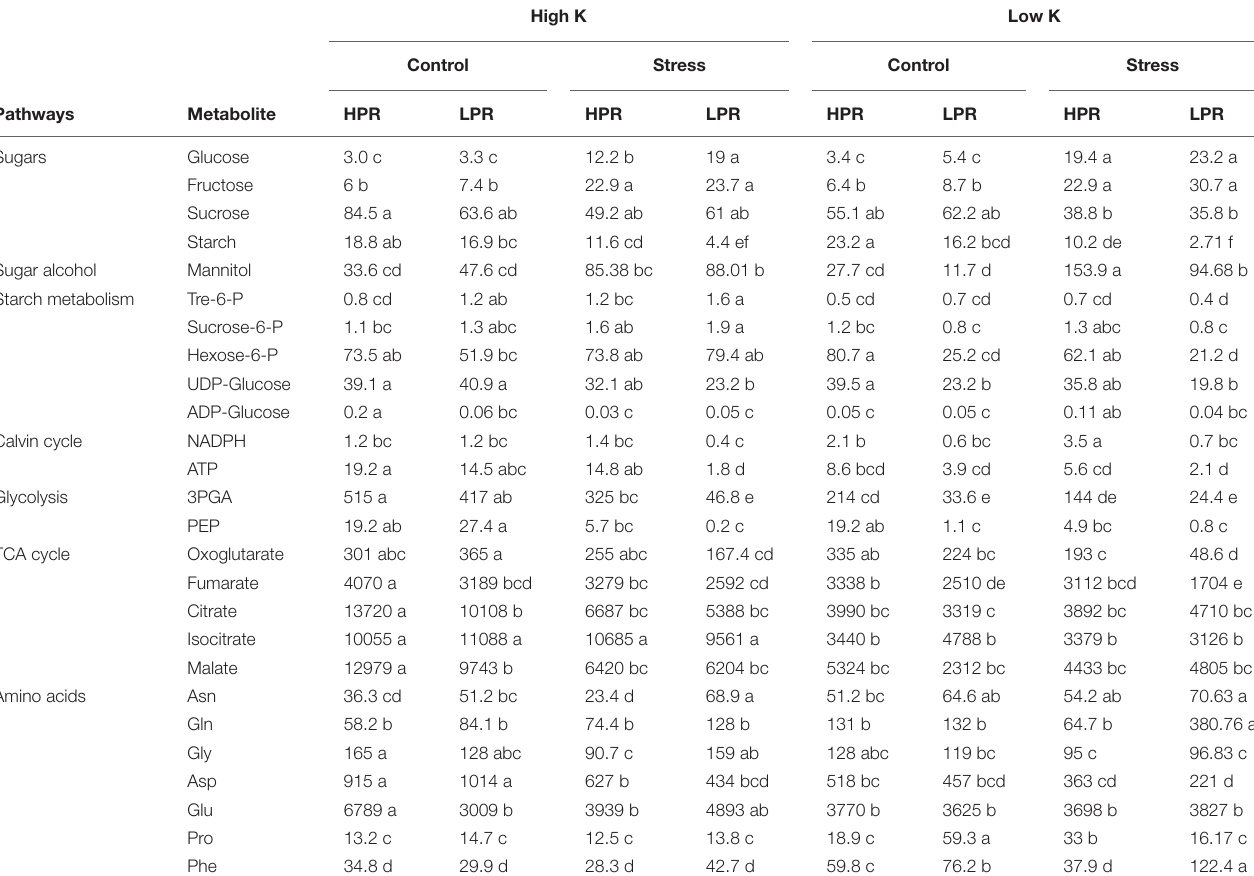
TABLE 1 | Influence of K supply on metabolite concentrations in flag leaves of barley during terminal drought stress. High K Low K